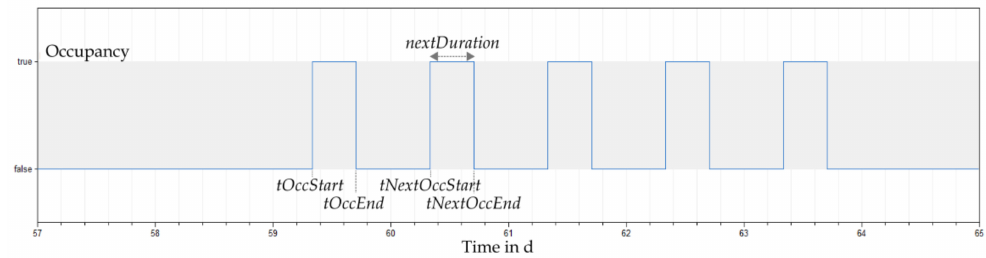
Figure 6. Occupancy signal (Supplementary